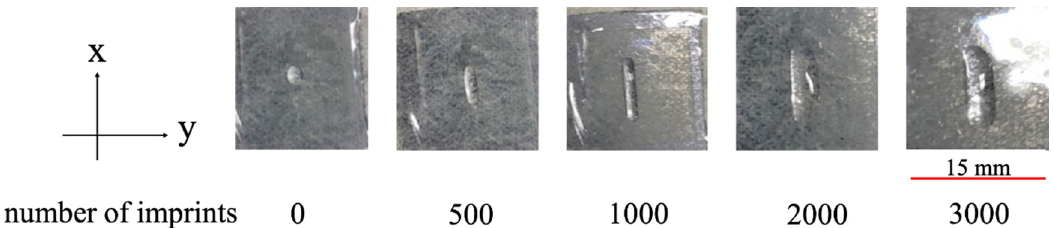
Figure 9. Water penetration distance for various imprint numbers. Table 1. Values assigned to Equation (5) for water penetration distance .